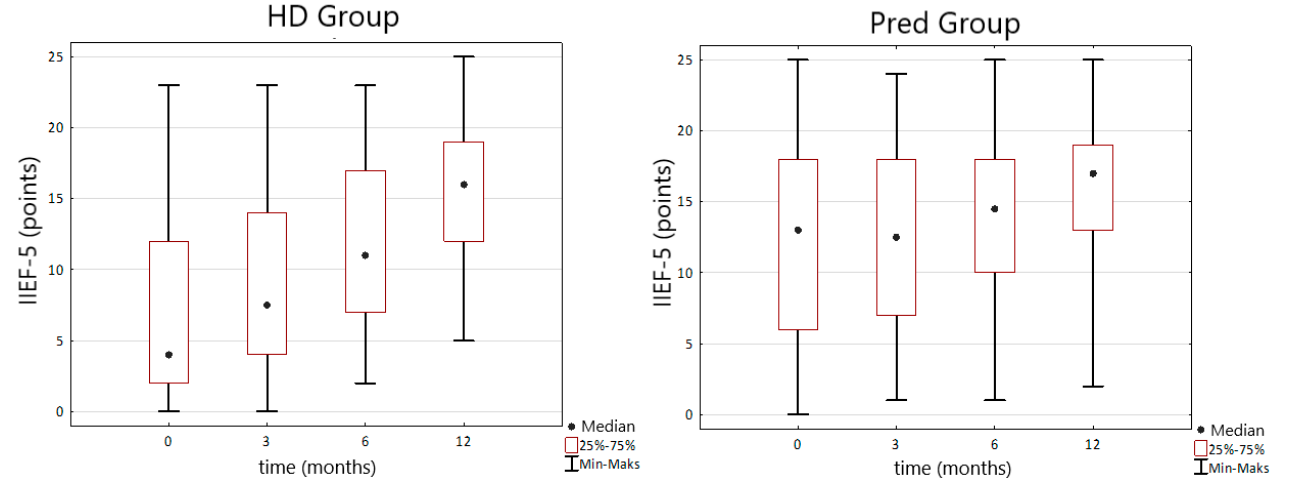
Figure 4. Changes in the IIEF-5 (international index of erectile functioning) score during TRT (testosterone replacement therapy) in the HD and PreD groups. 13.9 ± 1 kg/m 2 to 12.7 ± 0.8 ( p = 0.003) after 12 months in HD group. In the same